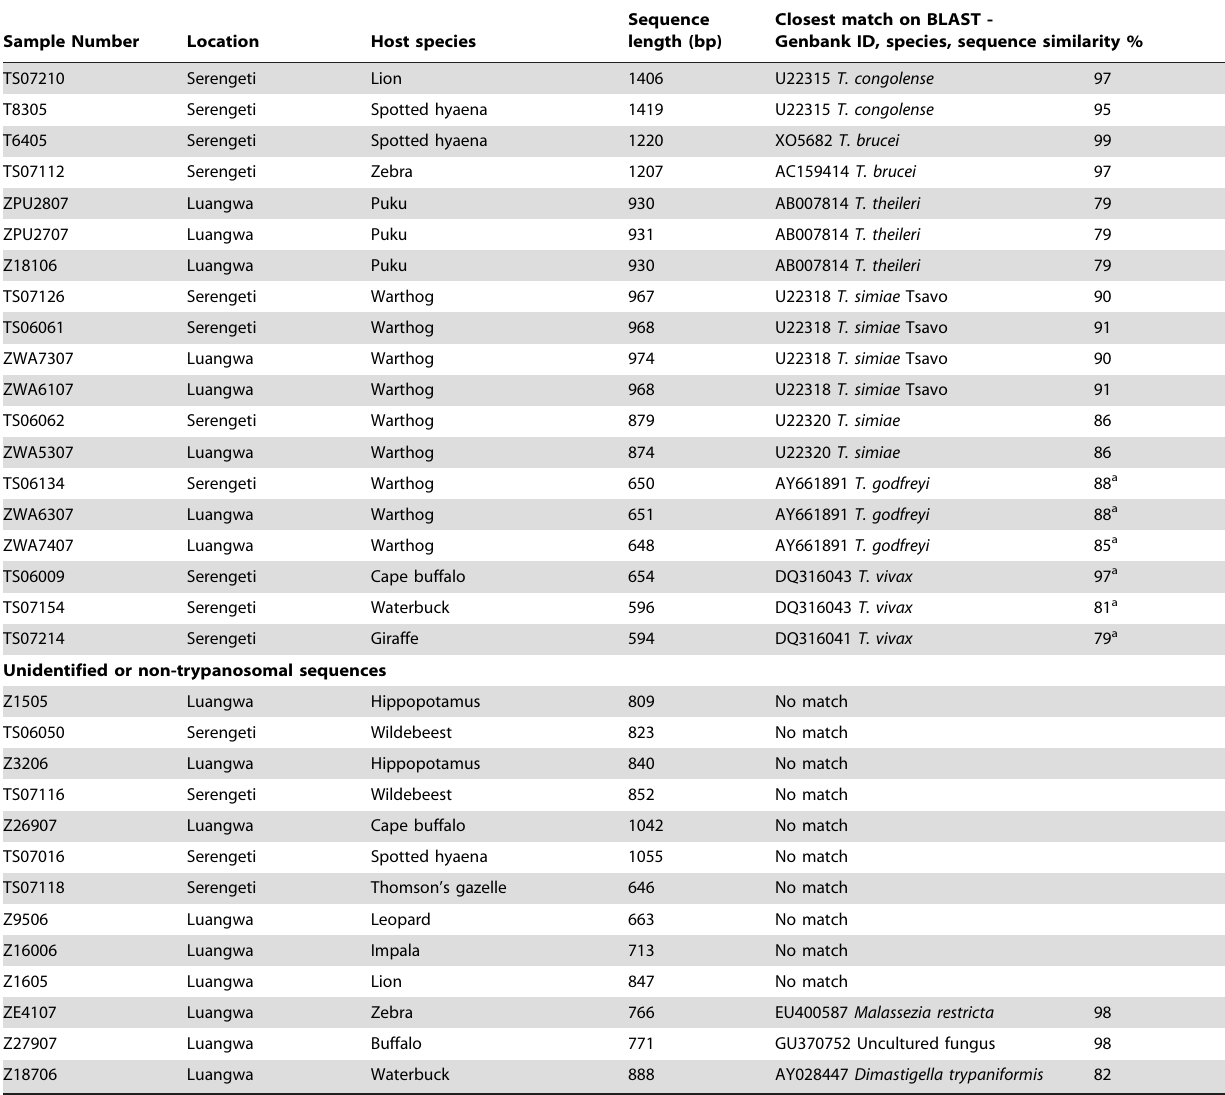
Table 3. Identification of sequences.